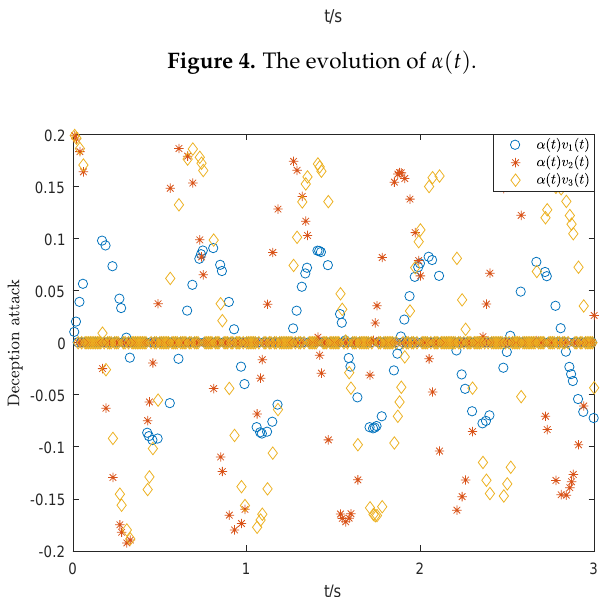
Figure 5. Deception attack α ( t ) v ( t )